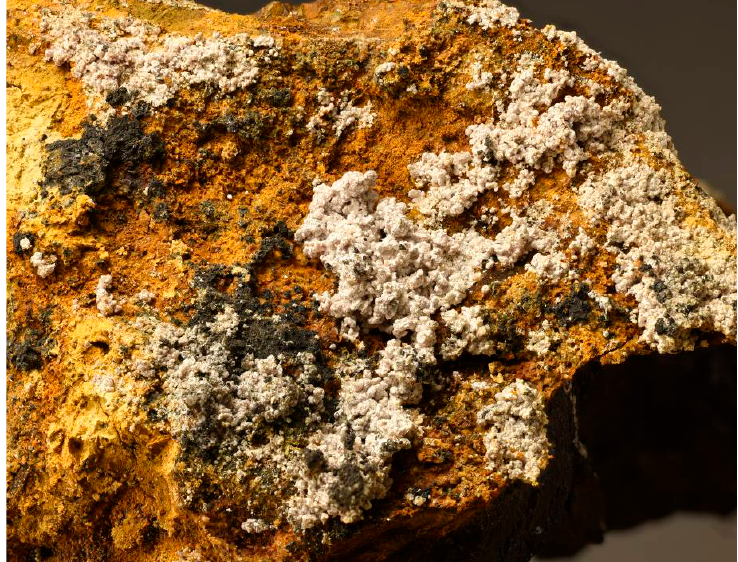
Figure 10. Fibroferrite from the Fornovolasco mine, as spongy fibrous aggregates. Field of view: 4 cm.